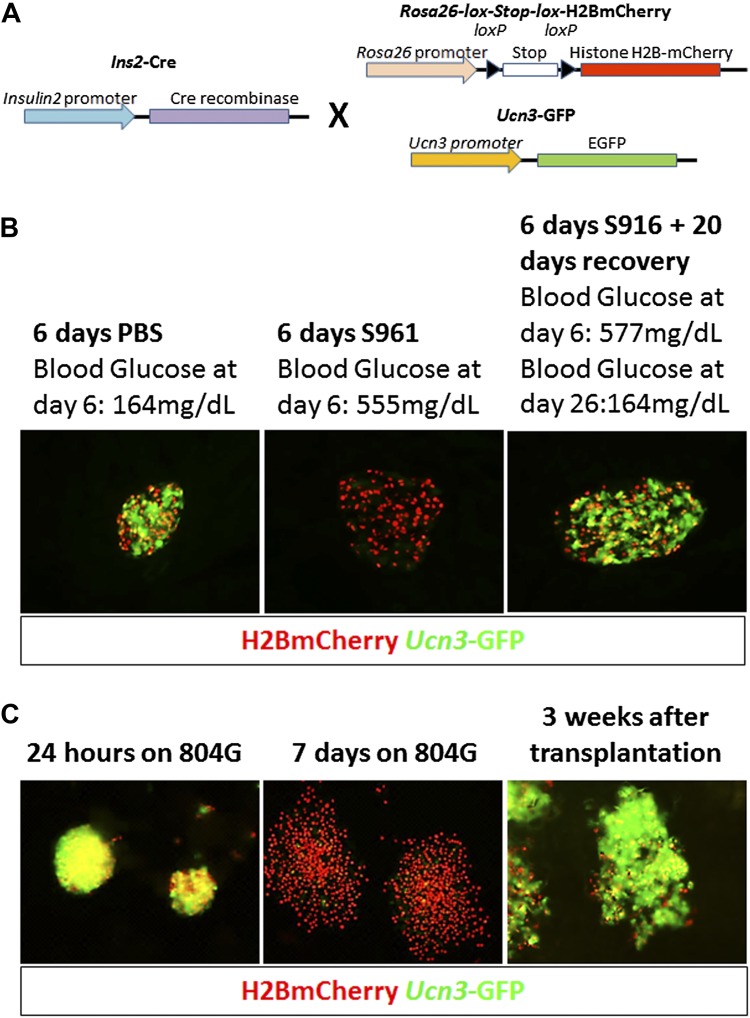
Adherent culture-induced β cell de-differentiation is reversible.(A) RCU reporter mice are made by crossing mice homozygous for the Insulin2-Cre transgene with mice doubly-homozygous for Rosa26-lox-stop-lox-H2BmCherry and Ucn3-GFP. Insulin expression in RCU progeny is permanently marked by red nuclear fluorescence, and Ucn3 expression is marked by green cytoplasmic fluorescence. (B) Pancreas sections of PBS-treated control and S961-treated diabetic RCU mice. Ucn3-GFP is reduced in diabetic mice, but not in controls, and Ucn3 expression returns after remission from diabetes. All images show live (unstained) reporter fluorescence. (C) De-differentiation and re-differentiation of RCU islets cultured in vitro. Islets from adult RCU mice were isolated and plated on 804G matrix for 1 week (left and middle panel). Note islet spreading and loss of Ucn3-GFP in the de-differentiated islets (middle panel). After 7 days, the de-differentiated islets were transplanted into euglycemic SCID mice for 3 weeks (right panel) after which time the transplants show the return of Ucn3 expression in β cells.